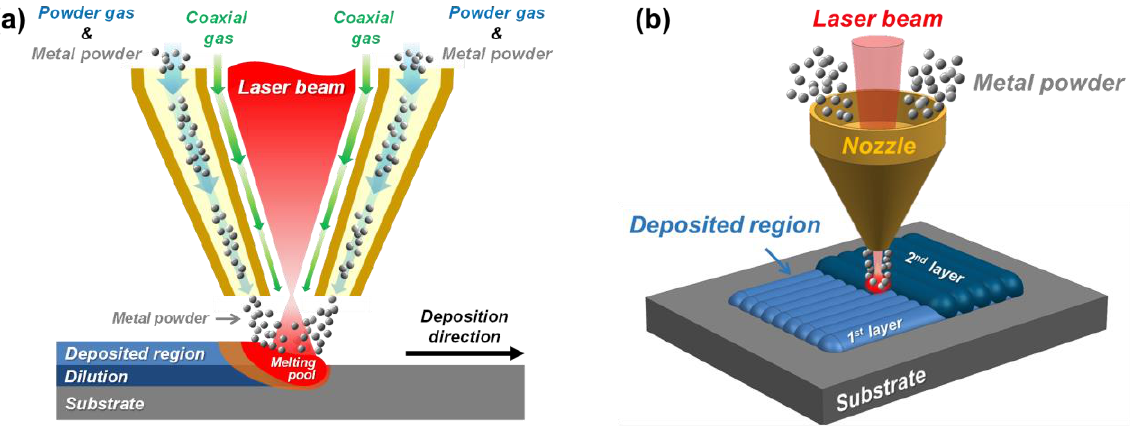
Figure 2. Schematics of ( a ) the powder-fed DED process and ( b ) multi-layered